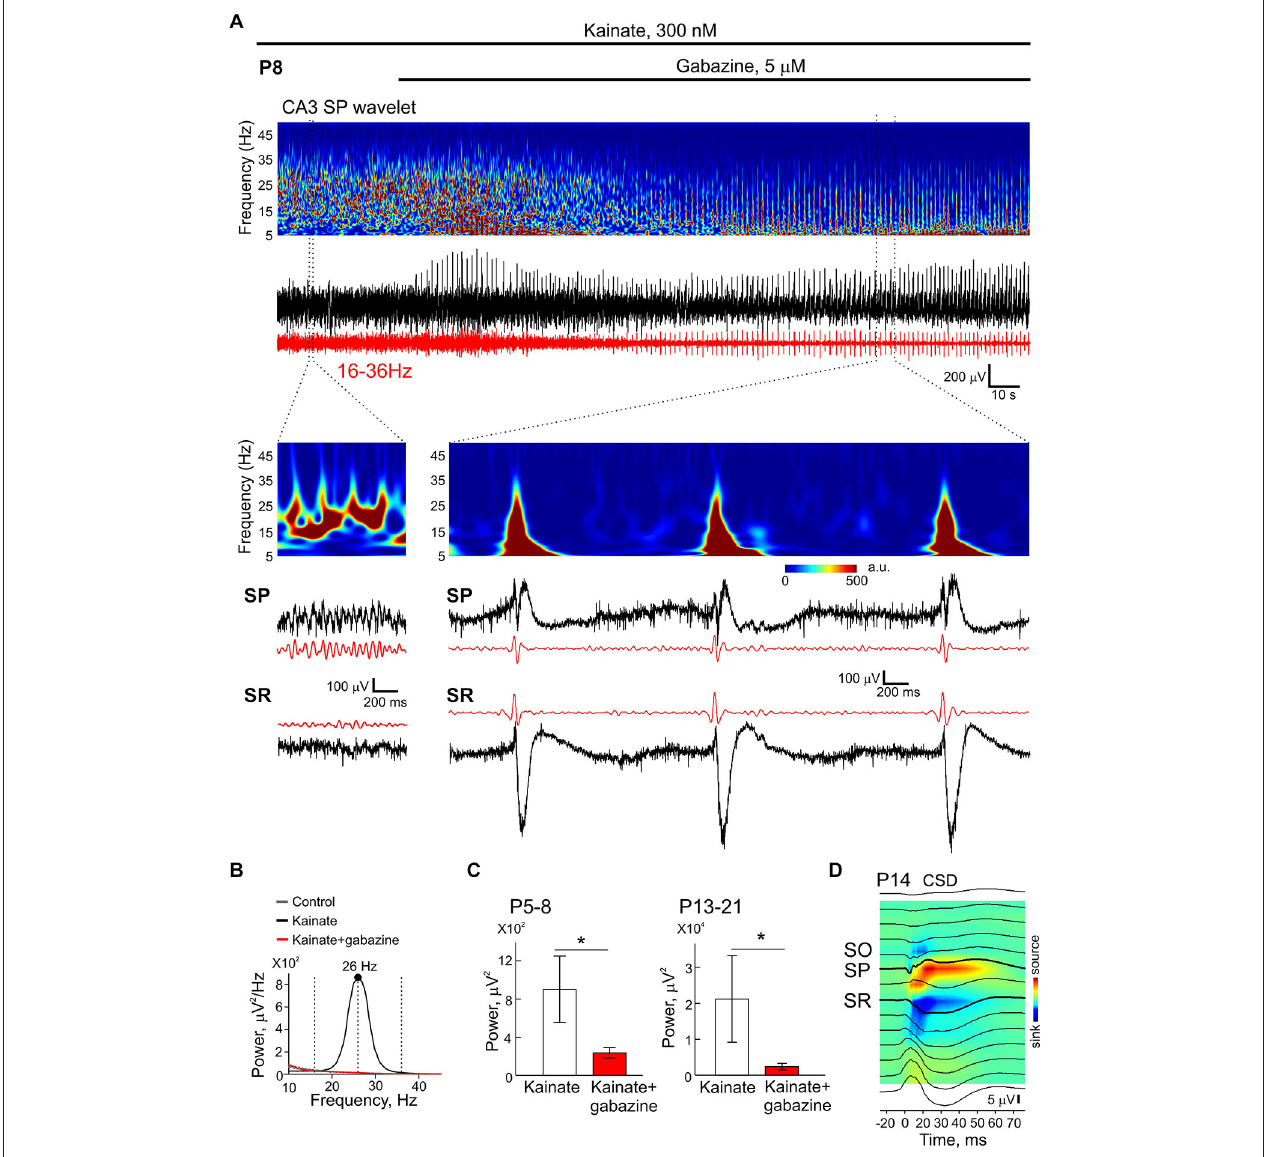
radiatum (SR). (B) Power spectral density of KA-Os presented on (A) before (black) and after (red) addition of gabazine. (C) Effect of gabazine on integral KA-Os’ power in two age groups. Pooled data from 8 (P5–8) and 4 (P15–21) slices. (D) Averaged epileptiform events ( n = 70 events) recorded in the presence of KA (300 nM) and gabazine (5 µ M) across CA3 layers and corresponding CSD. Note sinks in the stratum radiatum and